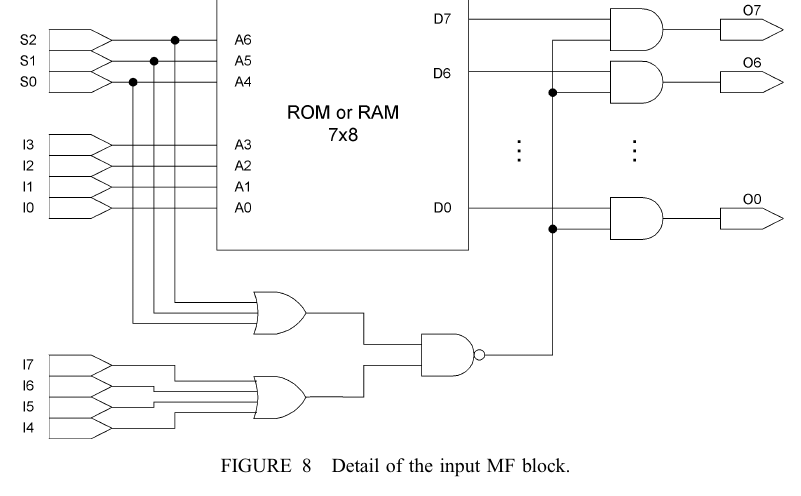
FIGURE 8 Detail of the input MF block.